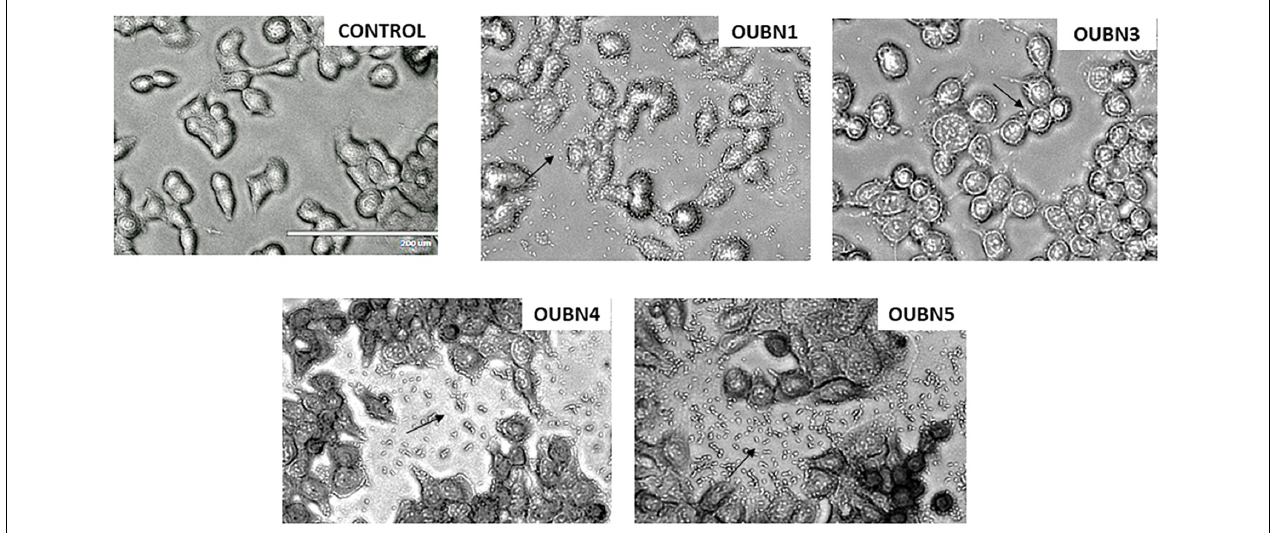
FIGURE 4 | Adhesion of LAB strains on HT-29 cell cultures observed under oil immersion microscope (100X) after staining with Giemsa strain. (Control)- HT-29 cell line without treatment and HT-29 cells treatment with OUBN1, OUBN3, OUBN4, OUBN5, respectively. Scale 200 µ m.